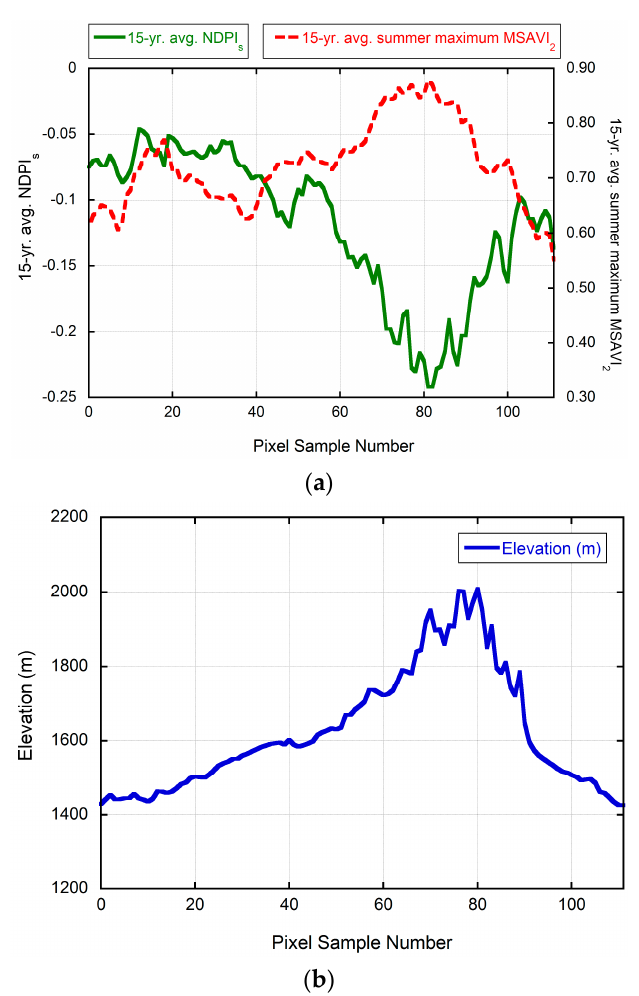
Figure 12. Variation in ( a ) 15-year averages of NDPI s and summer maximum MSAVI 2 ; and ( b ) topographic elevation, observed for individual pixels along a common transect (displayed in Figures 10 and 11) across the Huachuca Mountains in the southeastern part of the study area (Figure 2). Pixel sample numbers increase from the southwest to the northeast direction.